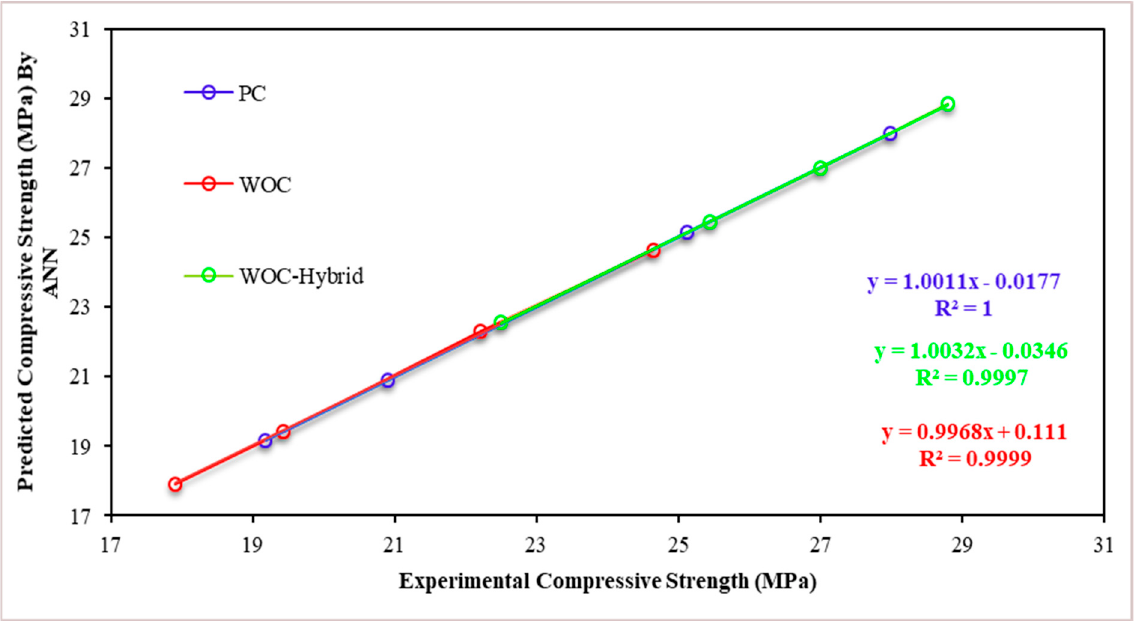
Figure 19. Linear relationship between measured and predicted compressive strengths (the Levenberg–Marquardt back-propagation algorithm).